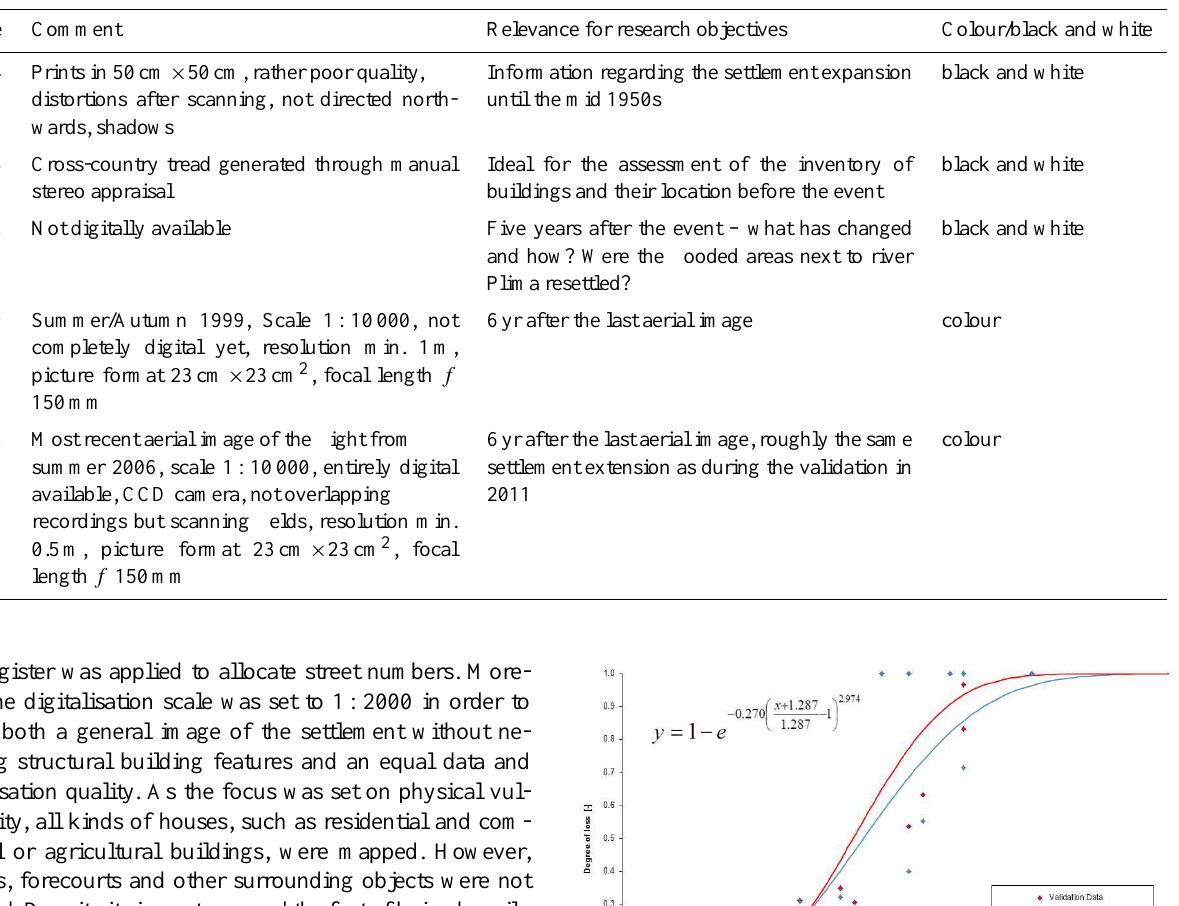
Table 1. Overview of the aerial images and their information (Autonomous Province of Bolzano, 2011c; University of Innsbruck, 2008).